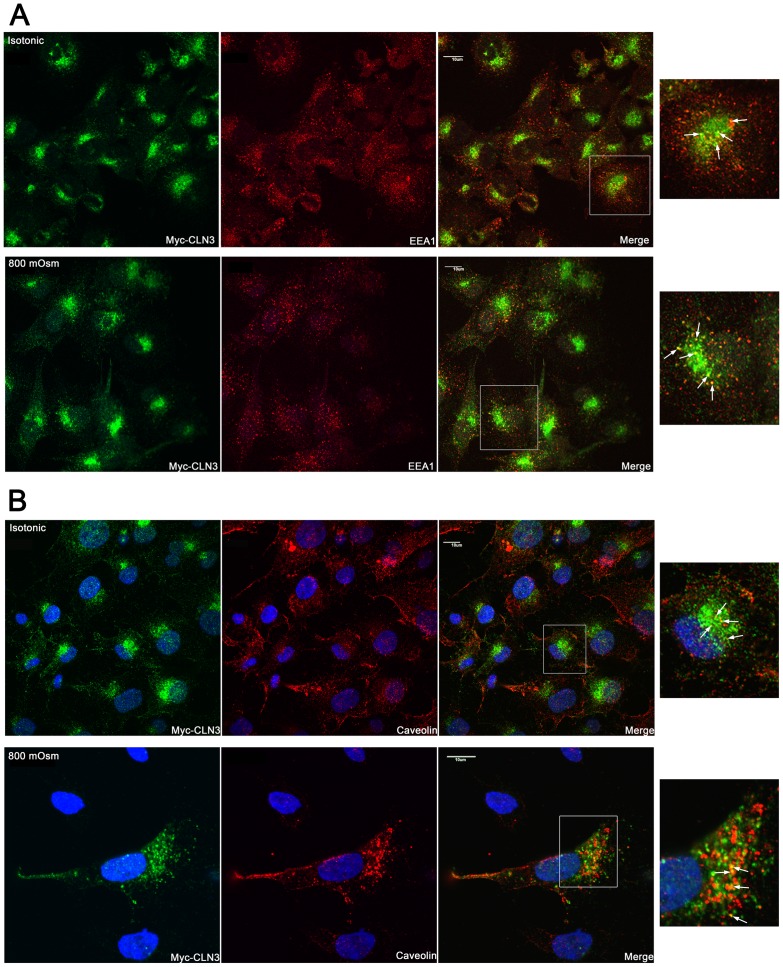
Under both isotonic and hyperosmotic conditions, a portion of myc-CLN3 is localized in early endosomes and in cholesterol/sphingolipid-enriched plasma membrane microdomain caveolae.BHK clone 19 myc-CLN3-expressing cells were grown on poly-D-lysine coated coverslips either under isotonic (300 mOsm) or hyperosmotic conditions. Osmolarity was increased at 100 mOsm intervals to 800 mOsm by the addition of NaCl/urea. After being exposed to 800 mOsm for 24 hours, cells were fixed, permeabilized and immunofluorescently stained for the myc-tag (to detect myc-CLN3; green) and for either the early endosomal marker, EEA1 (A) or the caveolae marker, caveolin 1 (B). In the merged images yellow indicates the colocalization of myc-CLN3 with EEA1 (A) or caveolin (B). The white-framed areas of the merged images are enlarged at the right side of the figure to highlight the early endosomal and caveolar localization of myc-CLN3. Arrows in the enlarged images point to colocalizations. Images were taken with a confocal microscope. Scale bars indicate 10 µm.